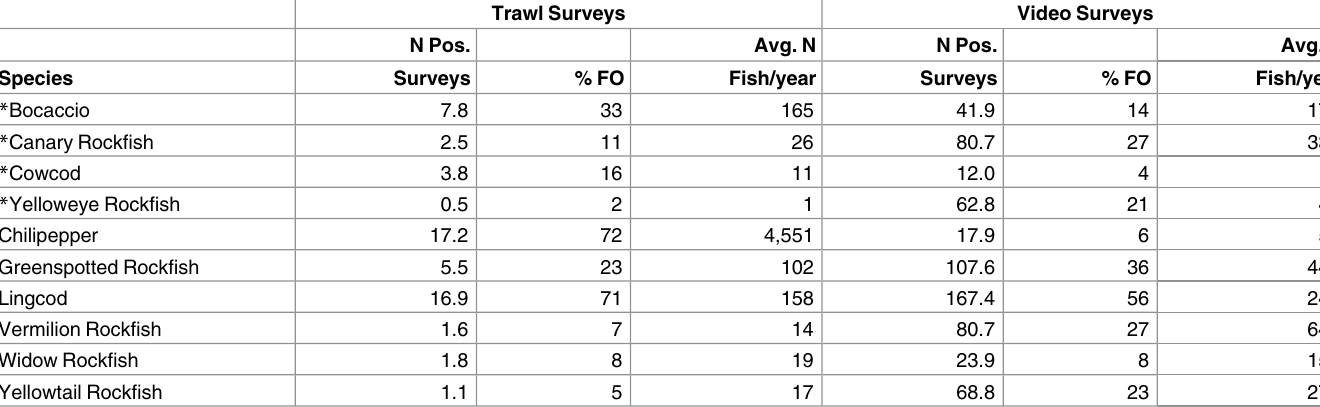
Table 10. Mean number of positive occurrences in trawl tows or video surveys.